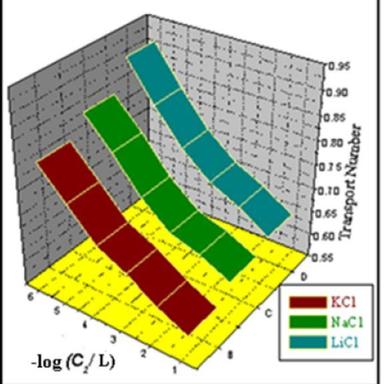
Plots of transport number against logarithm of concentration of PVC–NP composite membrane.